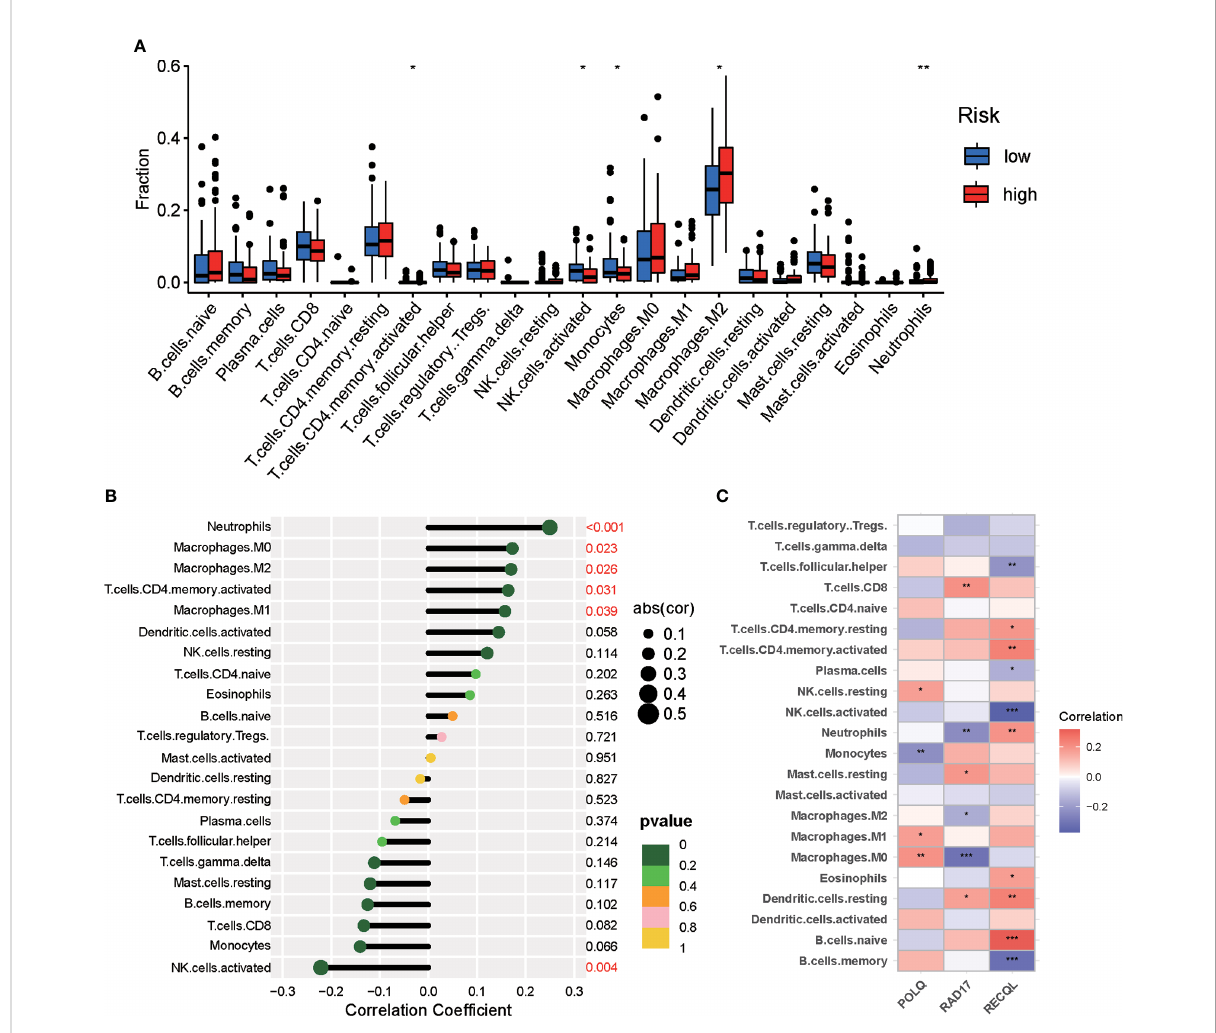
FIGURE 7 Differences in immune in fi ltration between the two risk groups of PAAD patients. (A) Violin plot demonstrating the ratio differentiation between the high-risk and low-risk groups for 22 types of tumor-in fi ltrating immune cells. (B) Correlation analyses between risk score and tumor- in fi ltrating immune cells in PAAD patients. (C) Correlation analyses for the expression of three DRGs and tumor immune cells. * p < 0.05, ** p < 0.01, *** p <